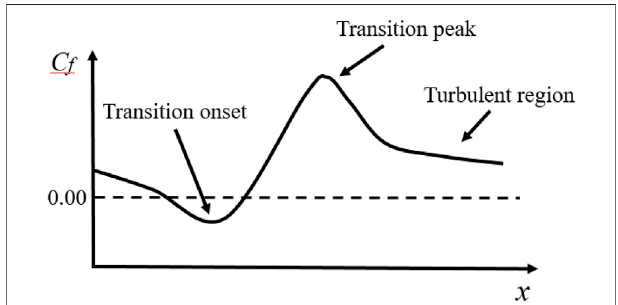
FIGURE 6 | Schematic diagram of the transition process.